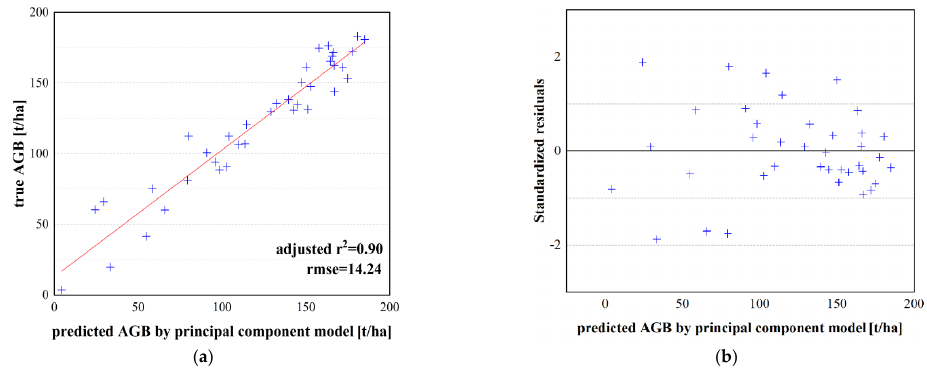
Figure 10. ( a ) Models established by principal component analysis; ( b ) residual analysis graph.